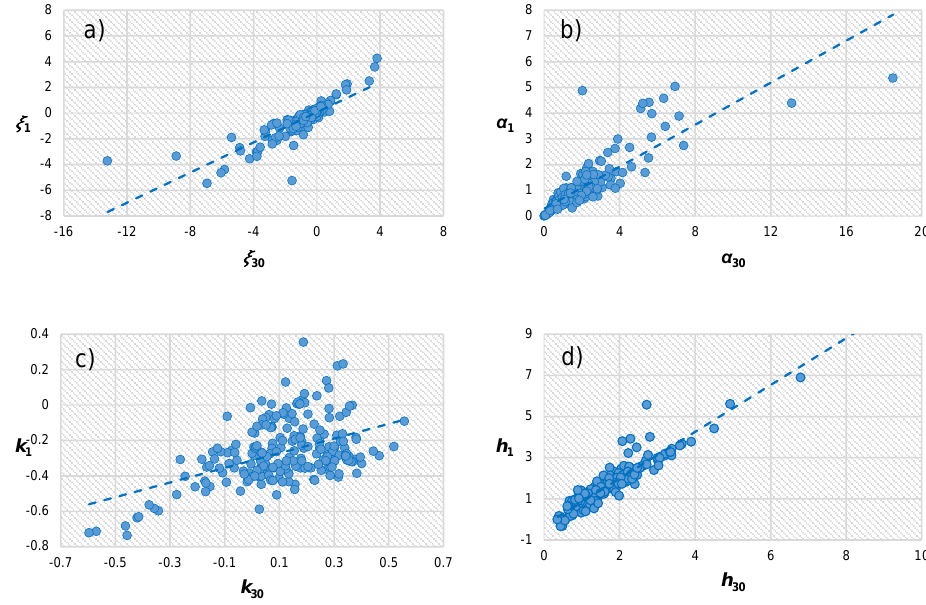
Figure 4. Scatter plots of four parameters at time scales 1 day and 30 day; ( a ) parameter 𝜉 ; ( b ); parameter 𝛼 ; ( c ) paramter k ; ( d ) parameter h .